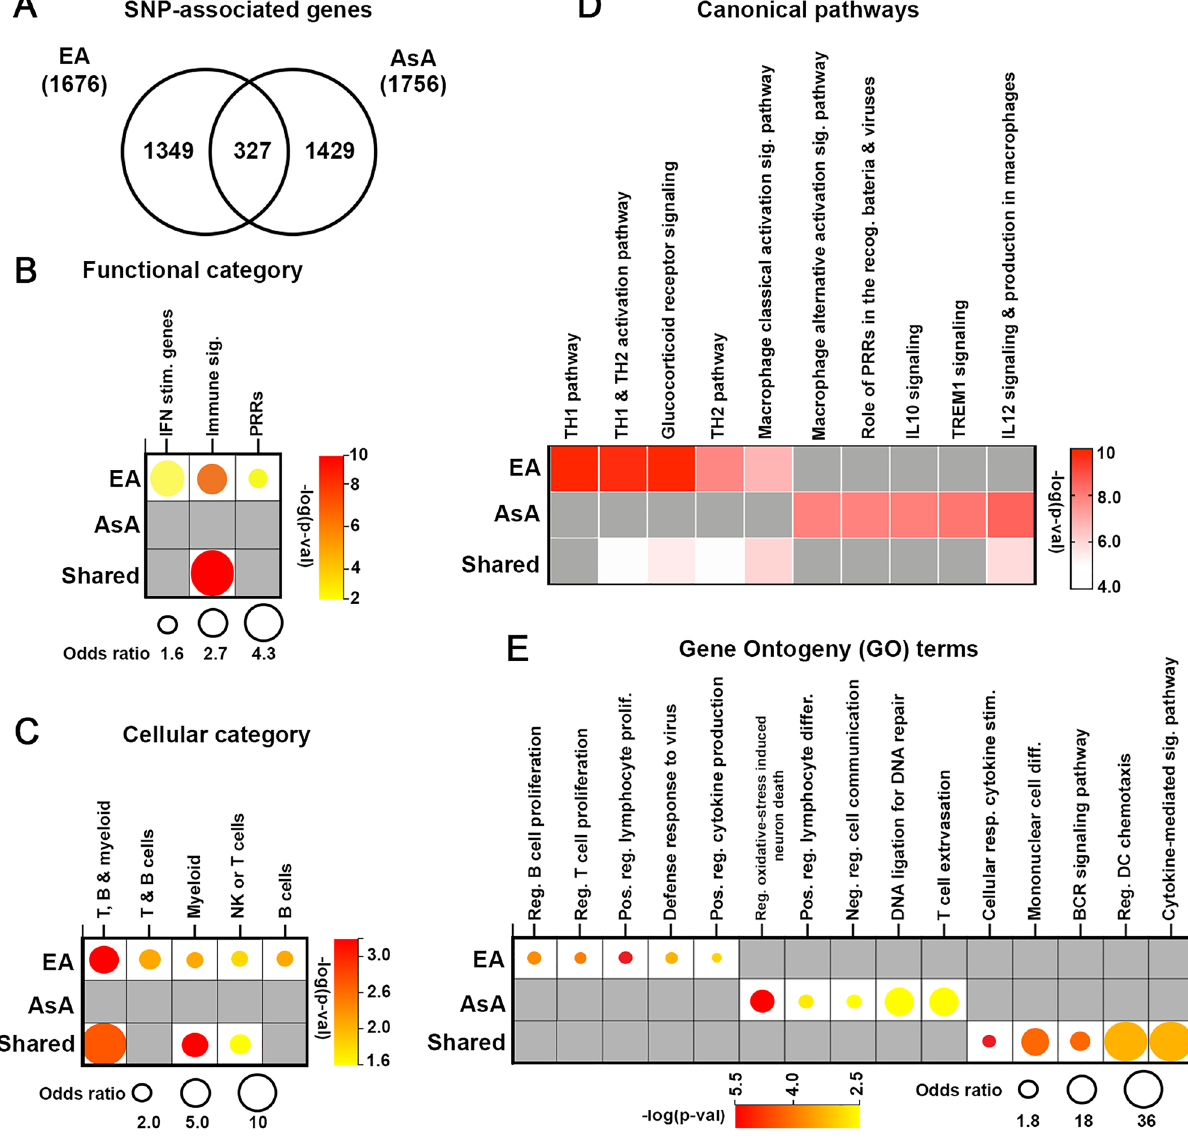
Figure 2. Functional characterization of SNP-associated genes. ( A ) Venn diagram depicting the overlap between all EA- and AsA-SNP associated genes. ( B , C ) Bubble plots depict ancestry-dependent and independent SNP-associated genes analyzed to determine enrichment using functional definitions from the BIG-C (Biologically Informed Gene Clustering) annotation library and I-Scope for hematopoietic cell enrichment. Enrichment was defined as any category with an odds ratio (OR) > 1 and a − log (p-value) > 1.33. ( D ) Heatmap (generated by GraphPad Prism 8.3; www. graph pad. com) visualization of the top five significant IPA canonical pathways and ( E ) bubble plot showing gene ontogeny (GO) terms for each gene list organized by ancestry. Top pathways with OR > 1 and − log (p-value) > 1.33 are